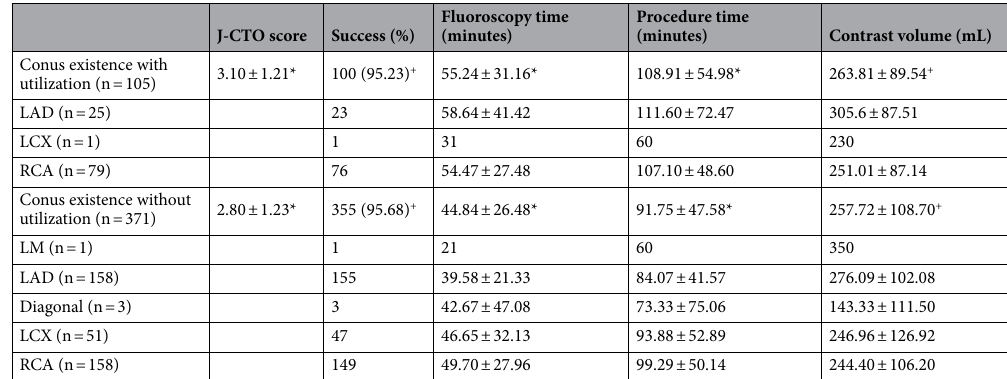
Table 4. Procedure Details Stratified by Utilization CBA and Target Vessel. LAD left anterior descending artery, LCX left circumflex artery, RCA right coronary artery, LM left main coronary artery. * p < 0.05, + p > 0.05, between with and without utilization